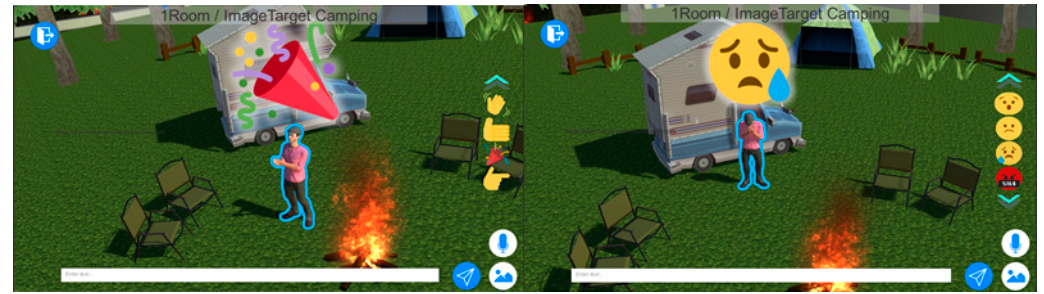
Figure 9. Character expressing emotions through emojis.